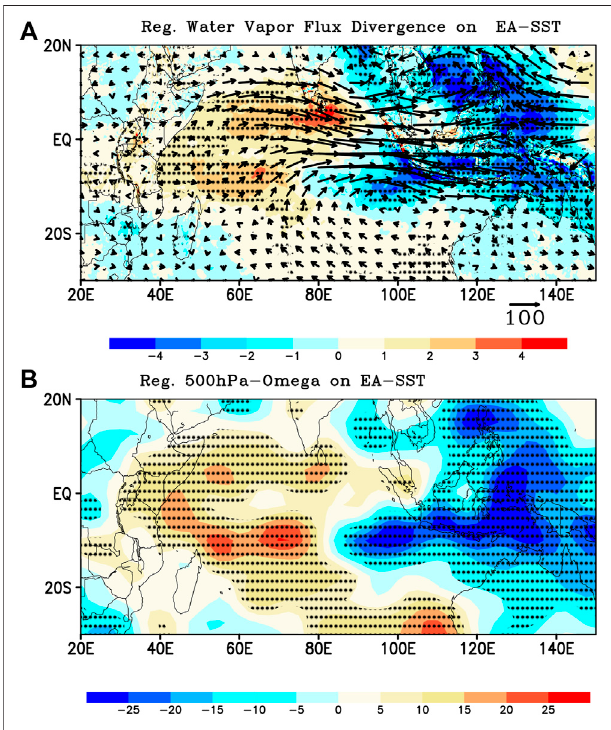
FIGURE 9 | Regressions of (A) divergence (10 − 5 kg s − 1 m − 2 ) of water vapor transport fl ux integrated from surface to 300 hPa (B) 500 hPa Omega (10 − 3 pa s − 1 ) against the EA-SST index during OND season for 1950 – 2017. Regions above the 95% con fi dence level are dotted.